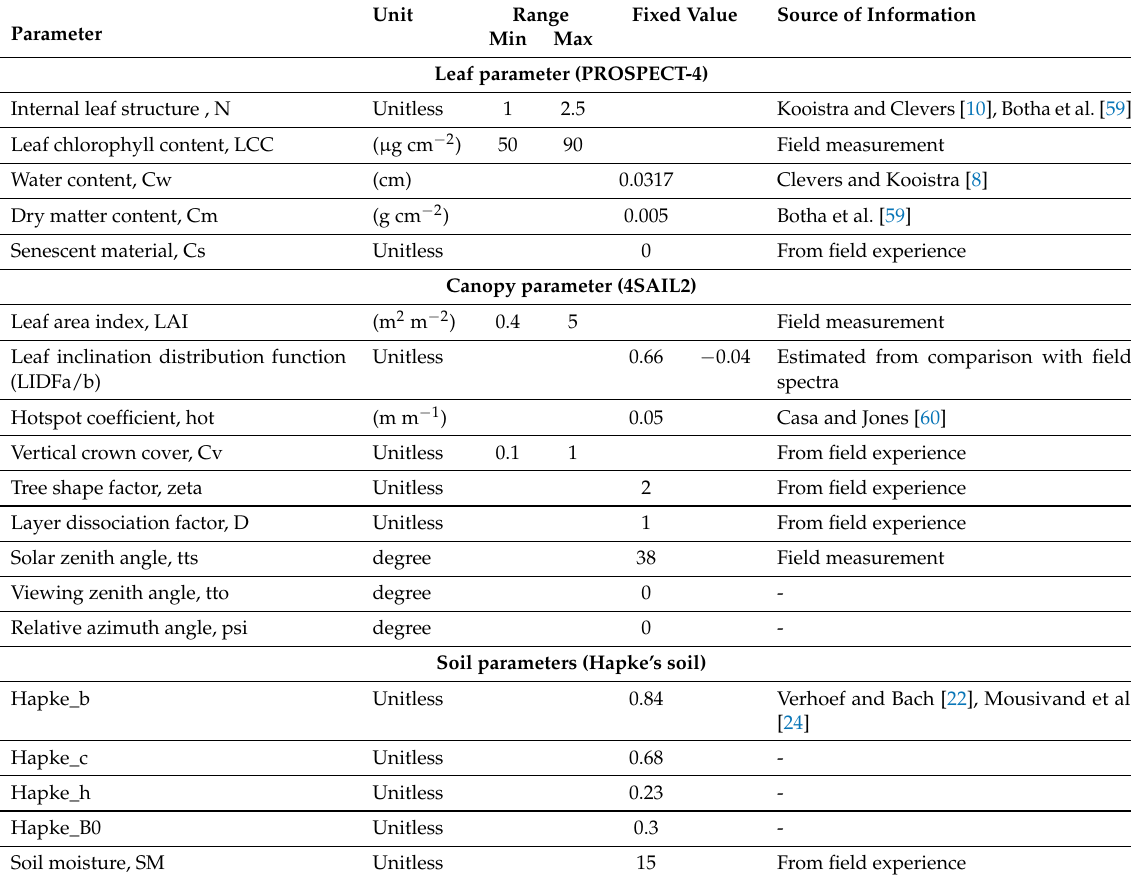
Table 1. Overview of the input variables in both types of look-up tables (LUTs) used for generating canopy spectra and for retrieving the target